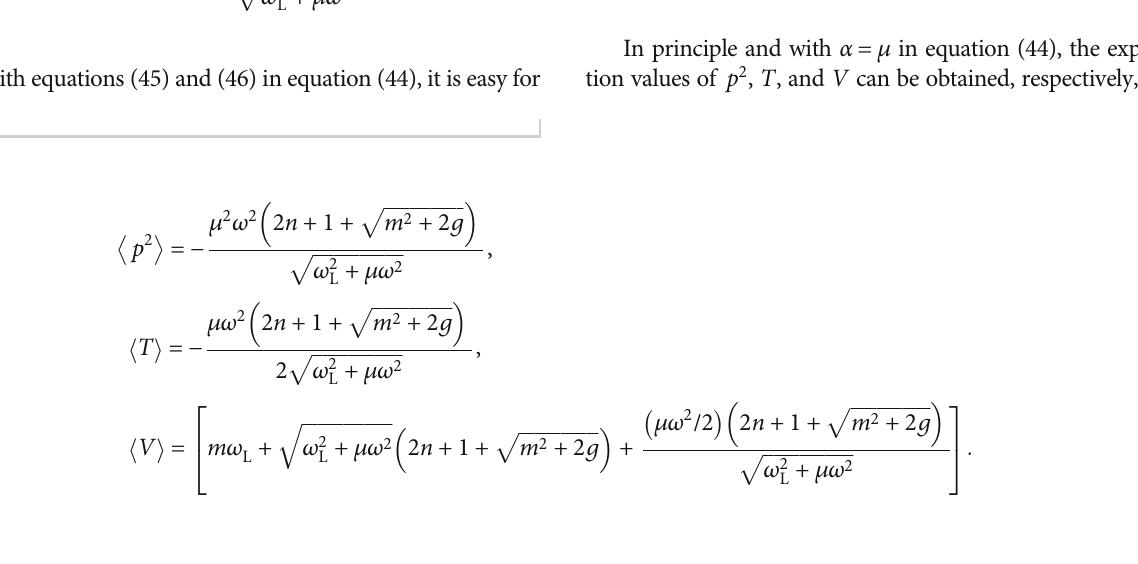
ffiffiffiffiffiffiffiffiffiffiffiffiffiffiffiffi ffiffiffiffiffiffiffiffiffiffiffiffiffiffiffiffiffiffi p ω 2 + μω 2 L